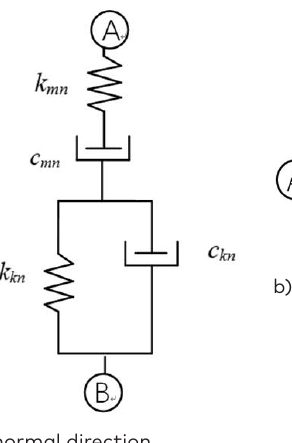
Figure 3 combined a spring element (aggregate elastic constitutive model) with the Burger model (mortar viscoelastic constitutive model) to describe the interaction between aggregate and mortar